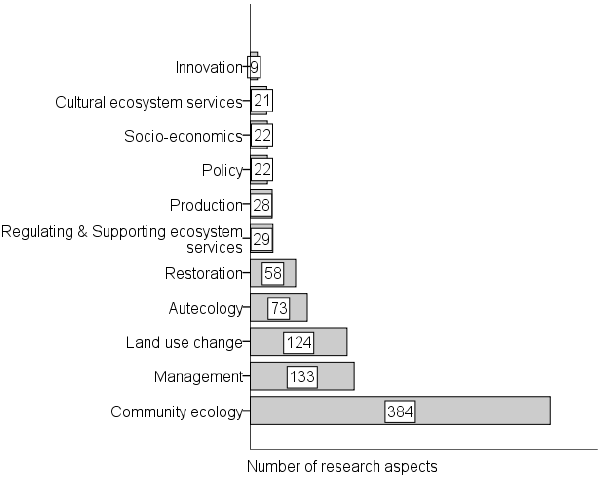
Fig. 3 . Research aspects identified in 562 papers relevant for semi-natural habitats in boreal Europe, with the number of publications for each aspect given in the white text box. Papers were assigned one to three aspects, and therefore the number of aspects exceeds the total number of